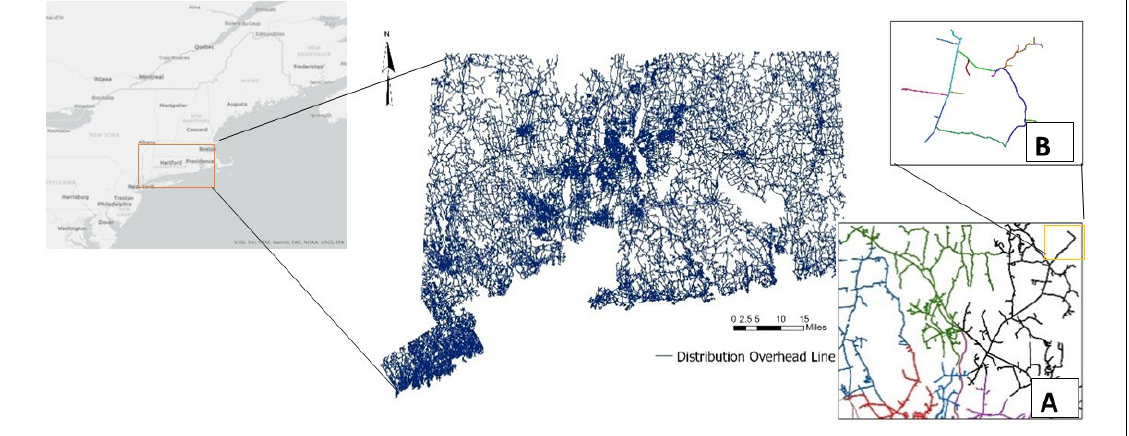
Figure 1. Map showing the distribution power line network (Eversource Energy) for the state of Connecticut. (A) Zoomed- in view of a circuit, (B) Zoomed-in view of a device exposure